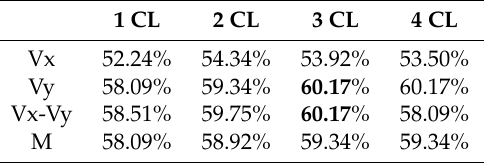
Table 4. Accuracies under various CNN architectures and optical flow